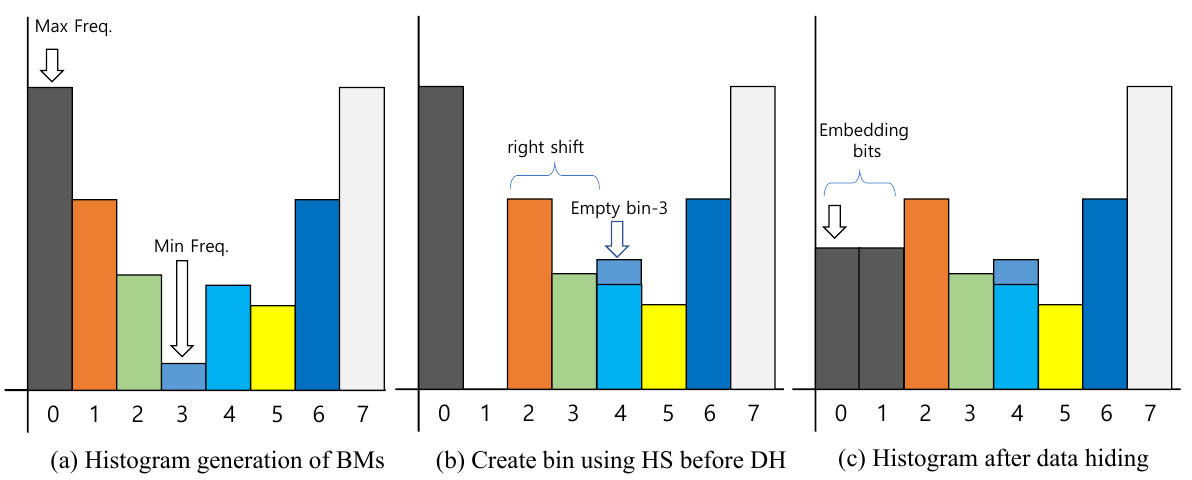
Figure 5. Embedding procedure using histogram